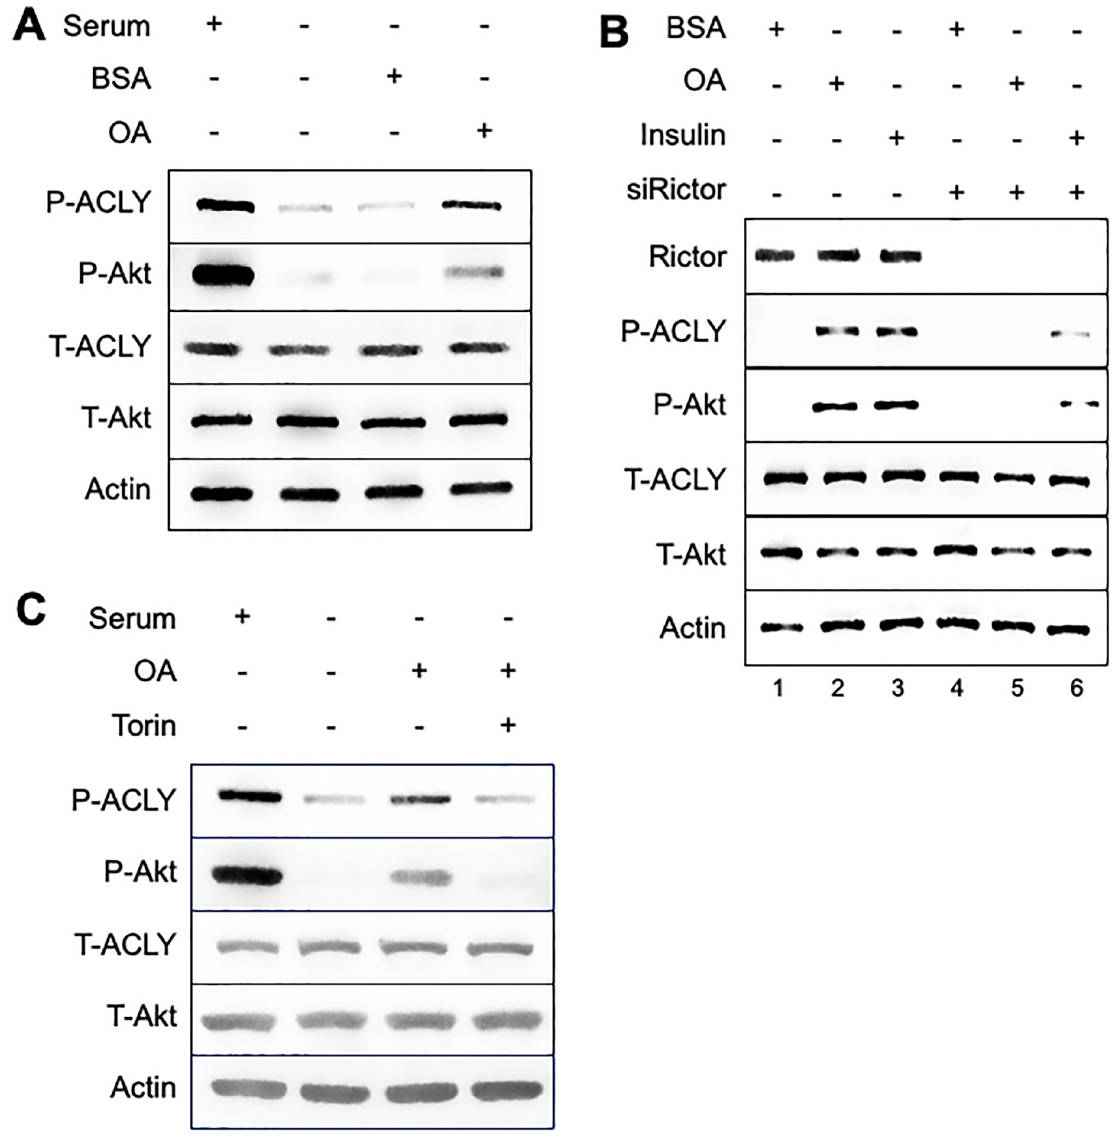
Fig 1. Oleic acid induces ACLY phosphorylation in an mTORC2 dependent manner. ( A ) HCT116 cells were plated at 60% confluency in complete medium (10% serum) and shifted to serum-free medium for 17 hr. OA (10 μ M):BSA in a 2:1 ratio was added for 60 min. Fatty acid-free BSA was used as a negative control since OA was carried in complex with BSA. Lysates were collected and analyzed for phosphorylated Akt (S473) and ACLY (S455) via Western blot. ( B ) HCT116 cells were plated at 50% confluency in complete medium. Knockdown of Rictor was carried out via Rictor siRNA (100 nM) (+) or non-targeting (-) siRNA for 72 hr. At the 48 hr point of knock down, the media was changed to serum free media for overnight. OA (10 μ M):BSA in a 2:1 ratio was added in presence or absence of Rictor. Insulin (100 nM) was also added to the HCT116 cells in the presence and absence of Rictor. Lysates were collected 60 min later and probed via Western blot for phosphorylated Akt and ACLY as in (A). ( C ) HCT116 cells were plated and treated as in A. Torin1 (1 μ M) was used as an mTORC2 inhibitor. Lysates were collected and analyzed by Western blot. BSA, bovine serum albumin. The Western blots shown are representative of experiments repeated at least three